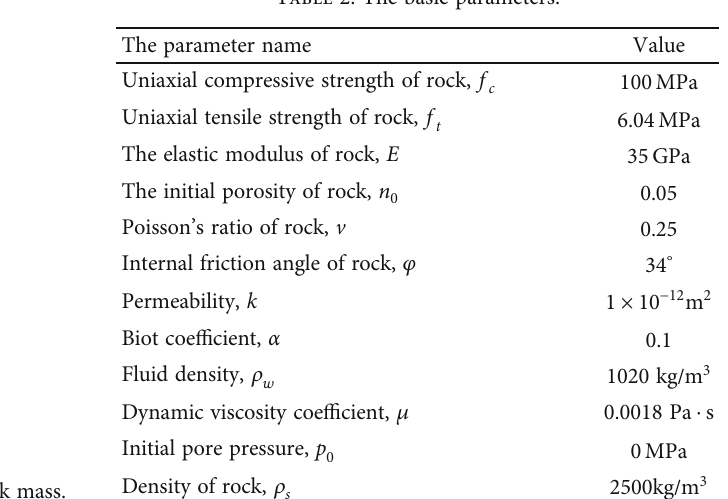
Table 2: The basic